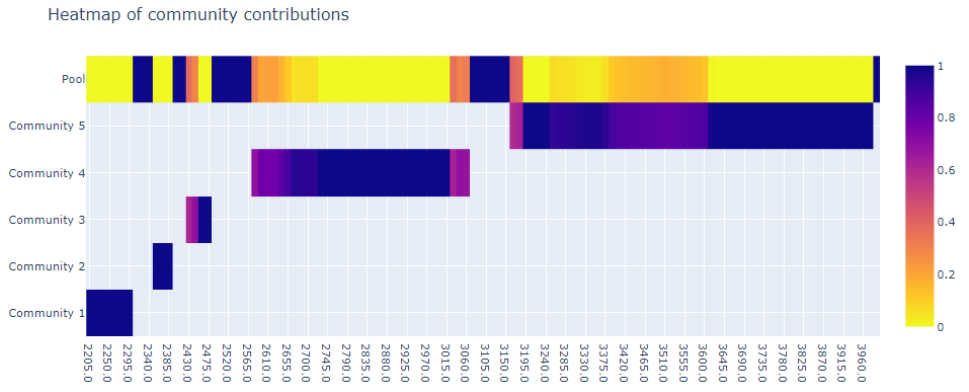
Figure 18. Complex communities for the first time window with